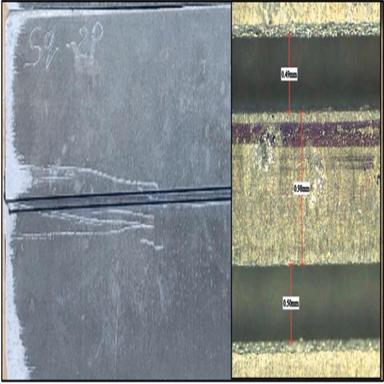
Stereo zoom image of AA6061 plate with double grooves cut for reinforcement filling.